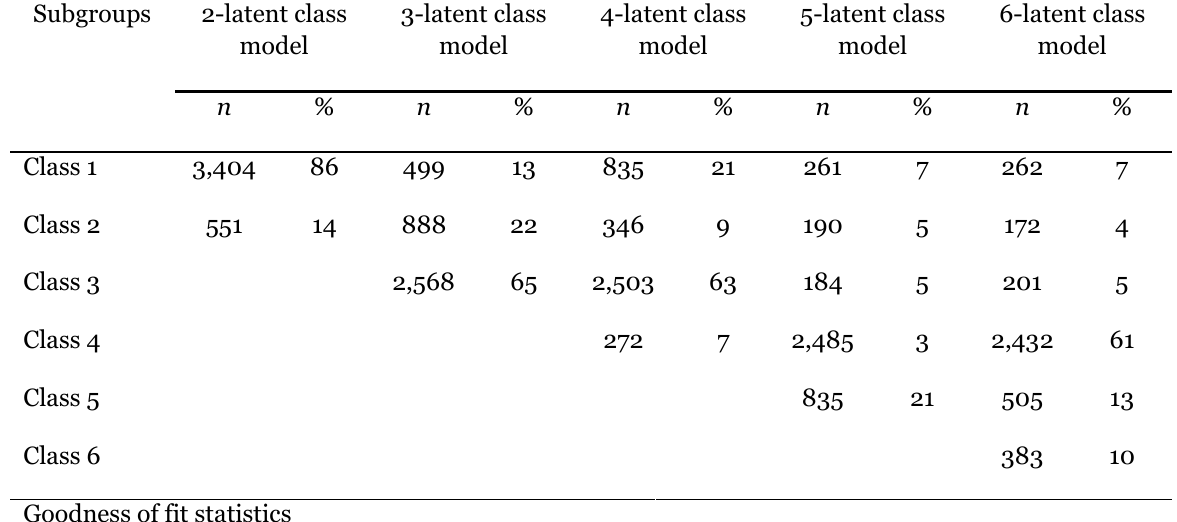
The Model Fit Information for Latent Class Models of MOOCs ( N = 3,955)